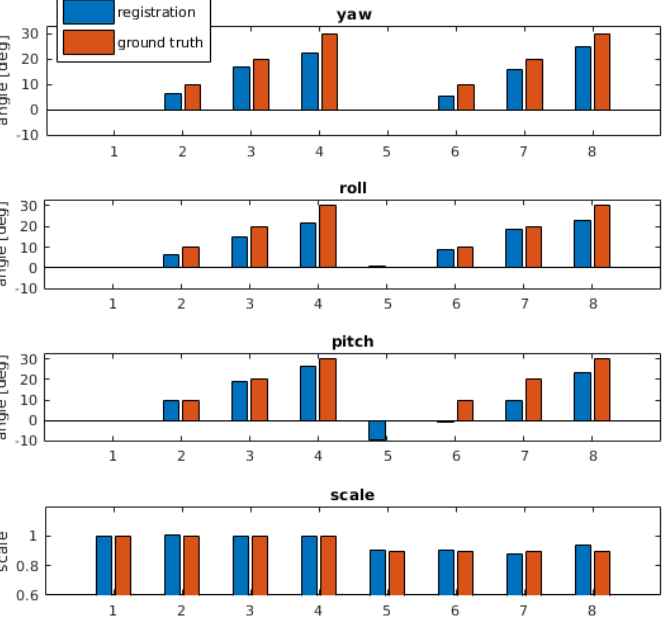
Figure 12. Results with artificial transformations. B1 (person 1, center position) is rotated up to 30 ◦ and scaled with the same rotation sequence. The segmented bone (person 1) is matched within the tissue of a MRT scan from person